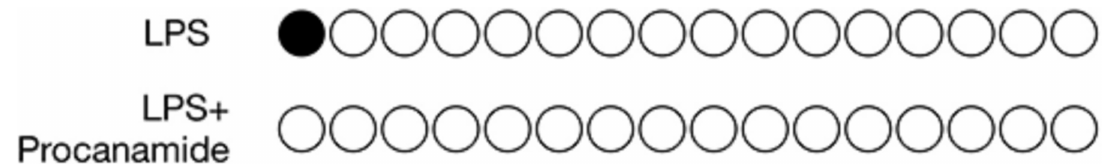
Fig 12. Effects of procainamide on IL27RA methylation in the lung of endotoxemic rat. The 532 bp amplicon correspondsto the rat IL27RA promoter region from -401 to +131 (from the transcription start site of IL27RA). Sixteen CpG dinucleotides within the CpG islands were examinedand denotedas open circle (unmethylated) and closed circle